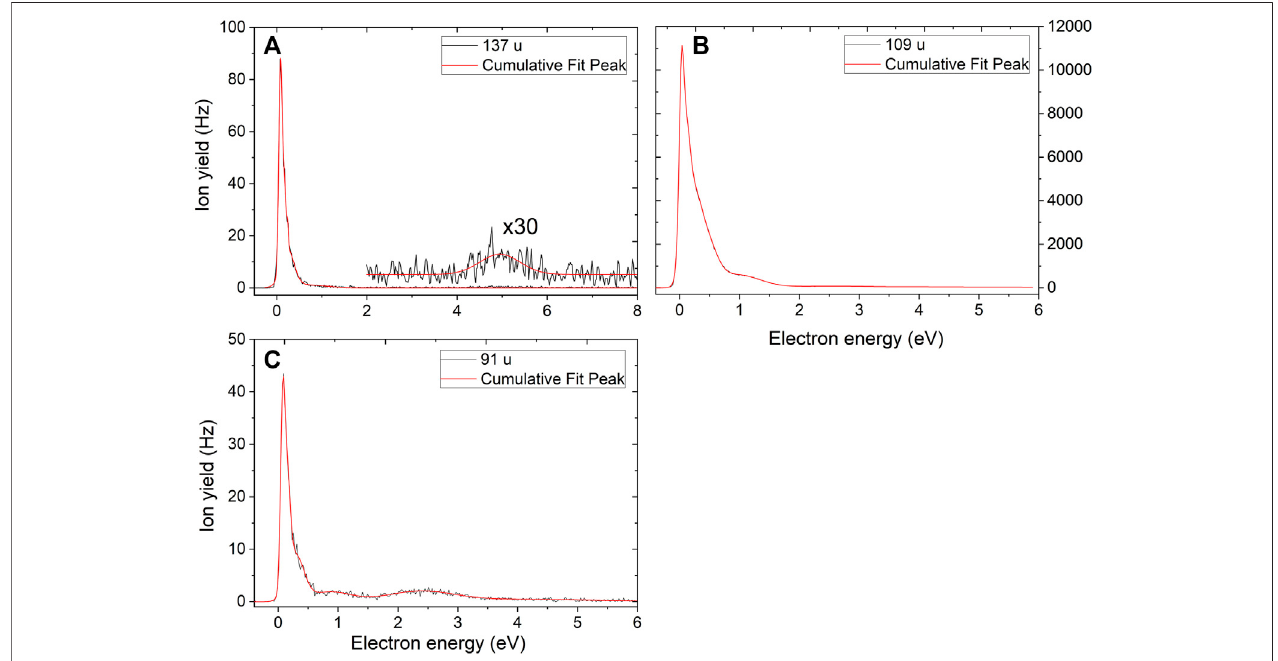
FIGURE 2 | (A – C) Anion ef fi ciency curves for the anions with masses 137, 109 and 91 u formed upon electron attachment to TMZ, respectively.